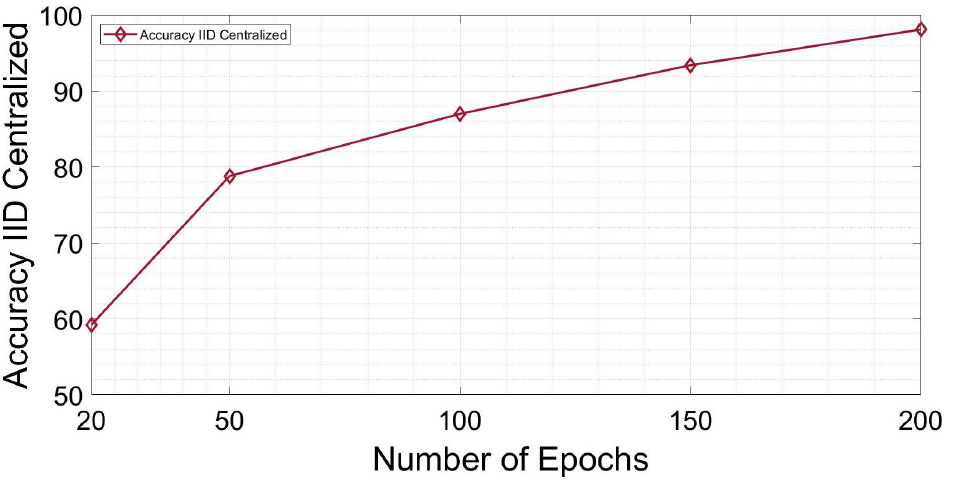
Figure 2. Accuracy in Centralized IID case of use.